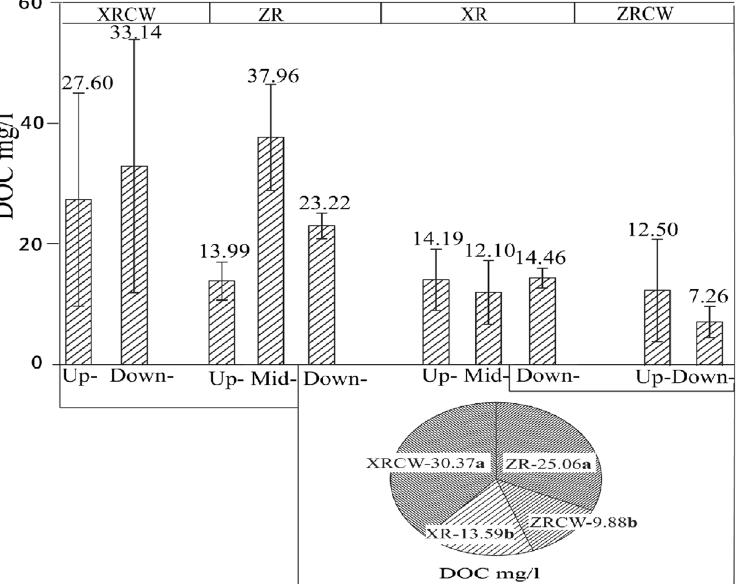
Figure 3. Cluster analysis and distributed difference of DOC among the four wetlands. Up/Mid/Down-ZR: upstream/midstream/downstream of Zhaoniu River. Up/Down-ZRCW: upstream/downstream of Zhaoniu River Constructed Wetland. Up/Mid/Down-XR: upstream/midstream/downstream of Xinxue River. Up/Down- XRCW: upstream/downstream of Xinxue River Constructed Wetland. Data with the same lowercase letter (a or b) are not significant at α = 0.05 (Duncan test).